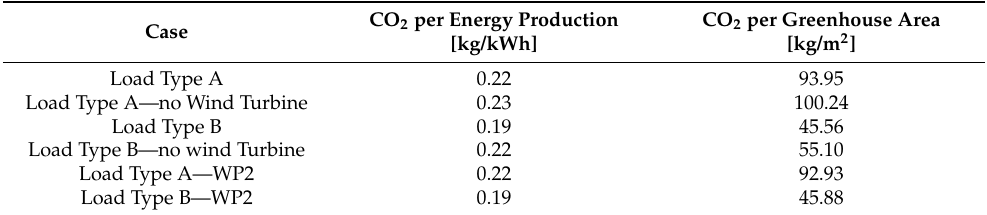
Table 9. Environmental footprint of the two greenhouse